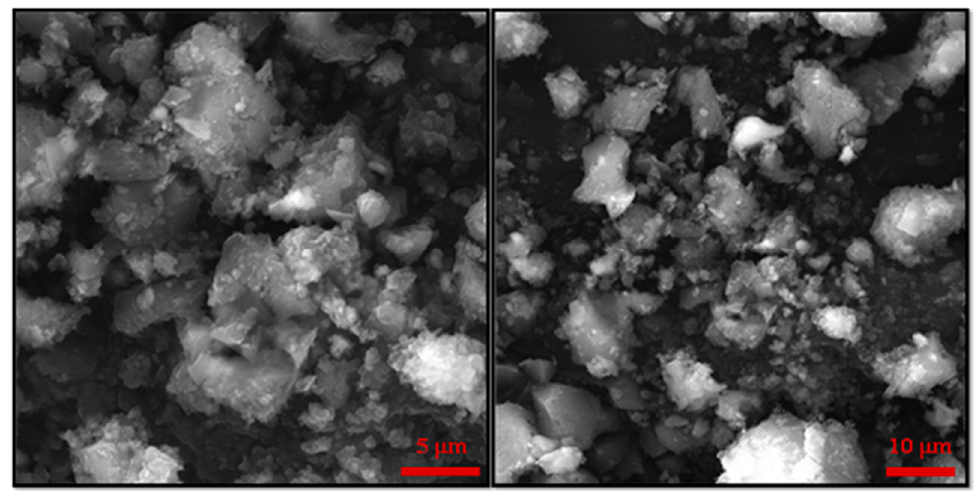
Figure 2. Additional, higher resolution SEM images for the sample CF MMOF.